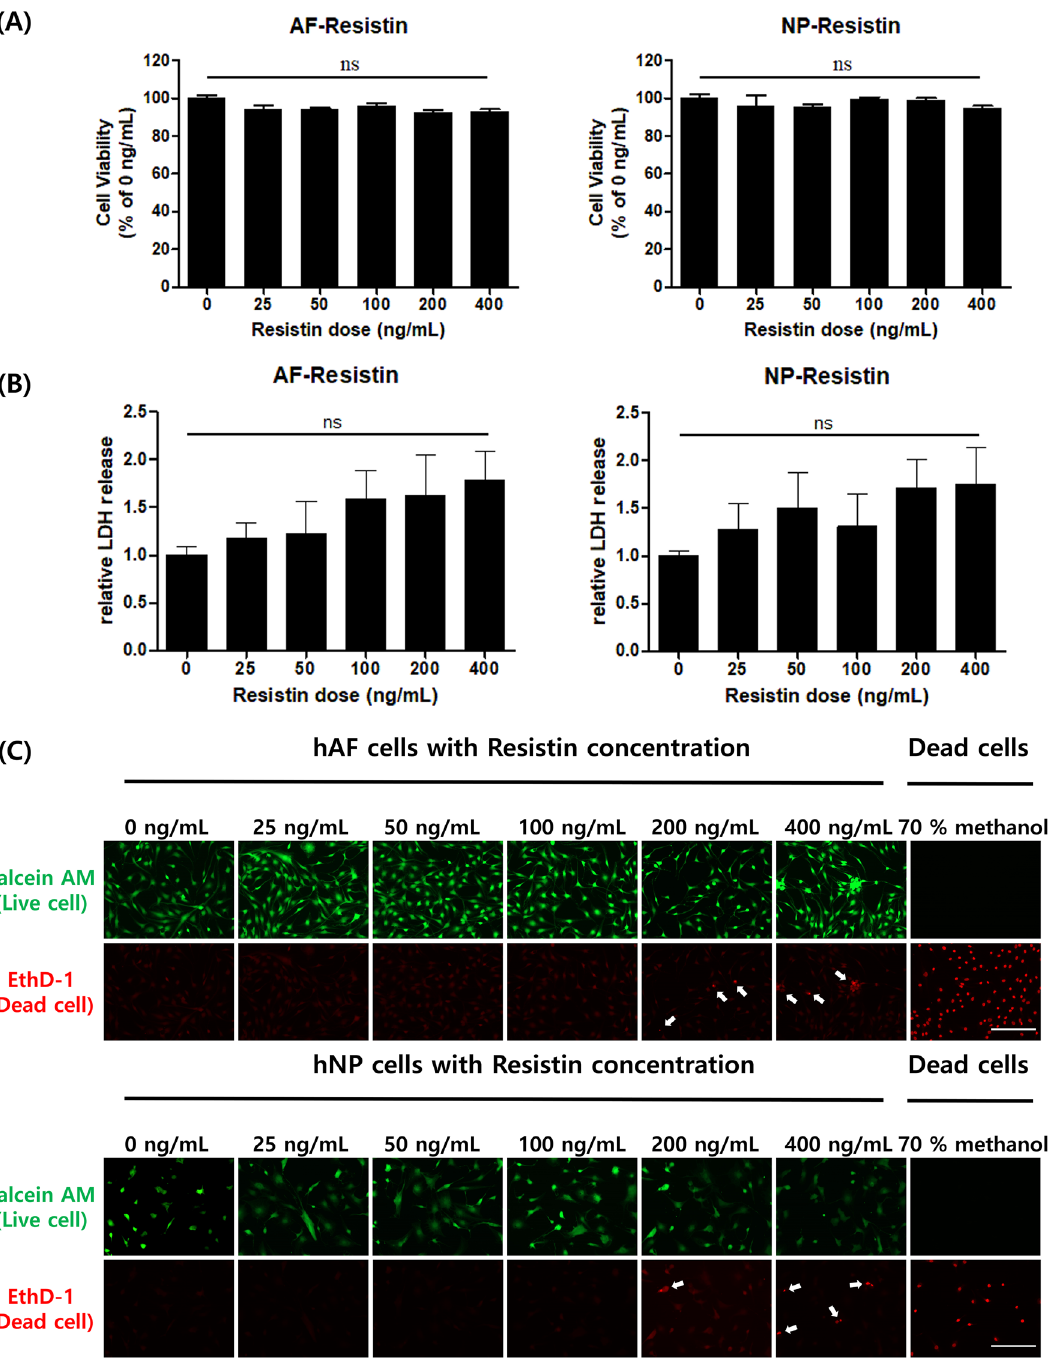
Figure 2. The mean ± SD of ( A ) viability, ( B ) cytotoxicity, and ( C ) fluorescence image (scale bar = 200 µm) of the live/dead assay of hIVD cells stimulated with six different concentrations of hResistin (0, 25, 50, 100, 200 and 400 ng/mL, n = 5/group) in